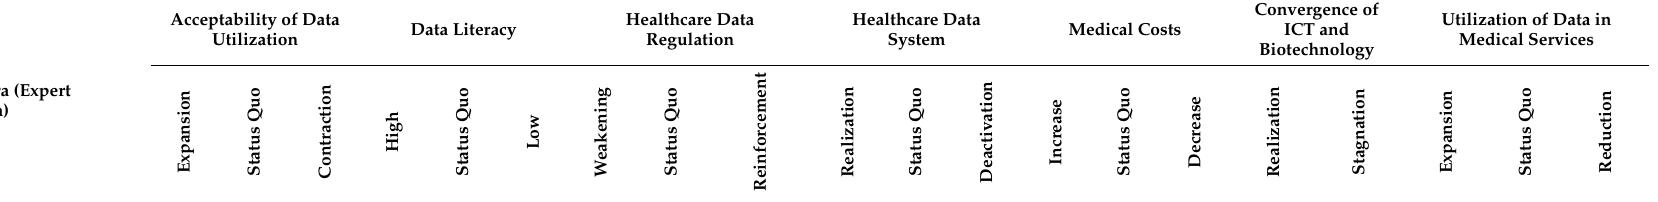
Table A1. Distance between Spectra (Expert Evaluation